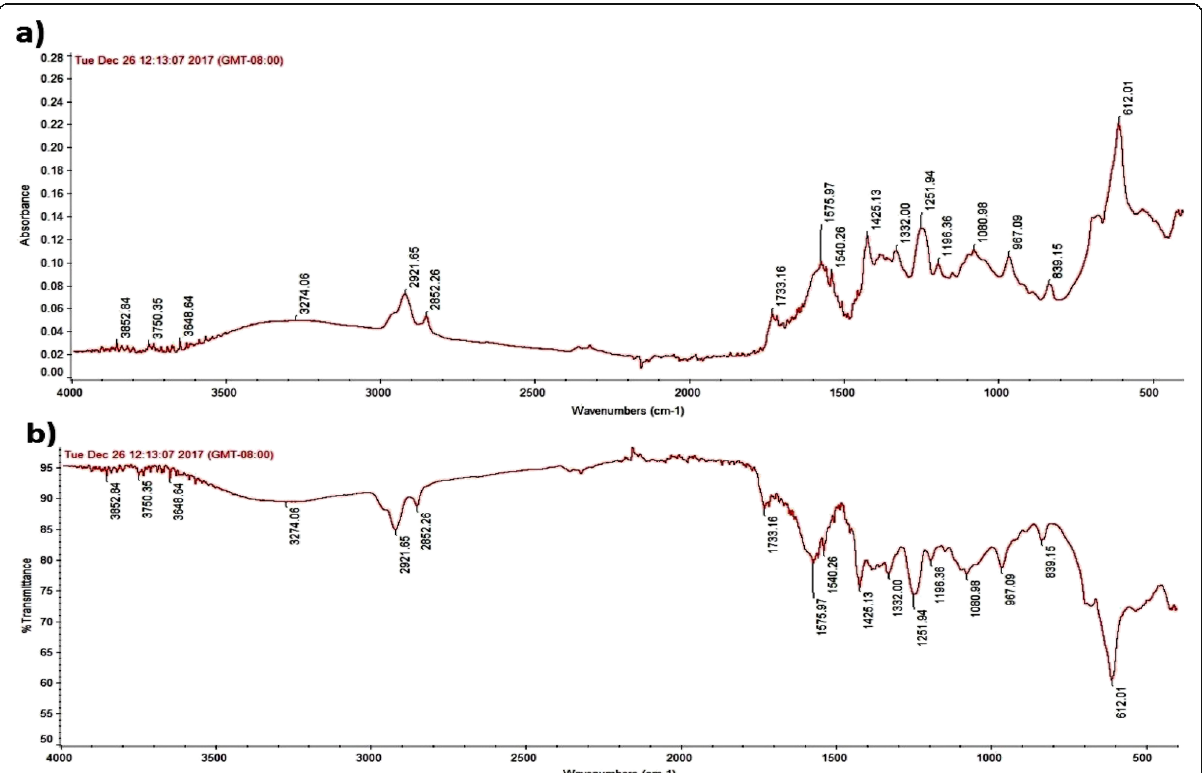
Fig. 3 The FT-IR showing a absorbance and b transmittance of the bioactive compounds in the M. oleifera leaves extract after incorporating